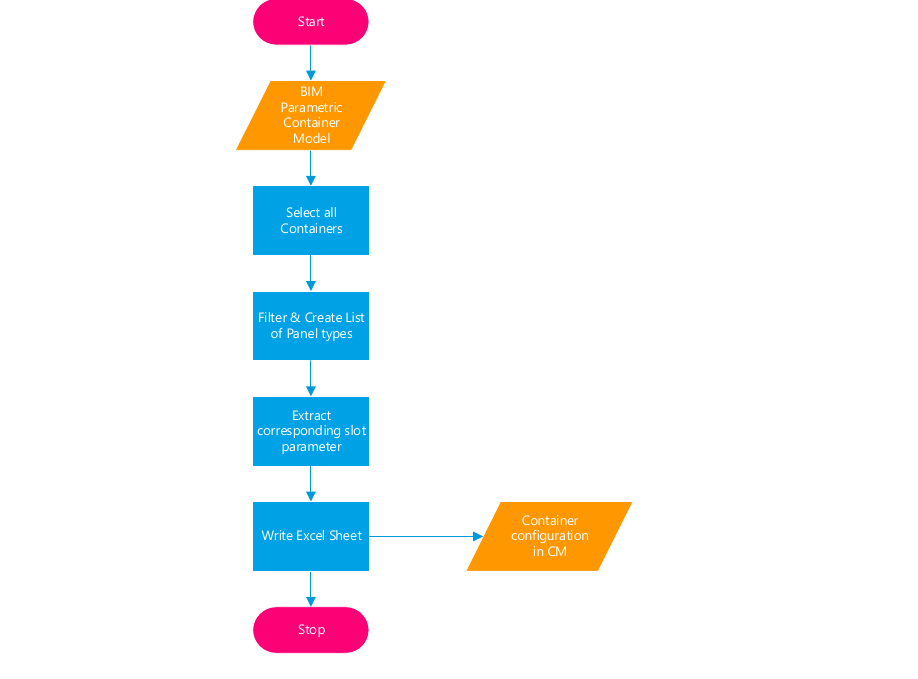
Figure 9. Export to Container Manager algorithm.